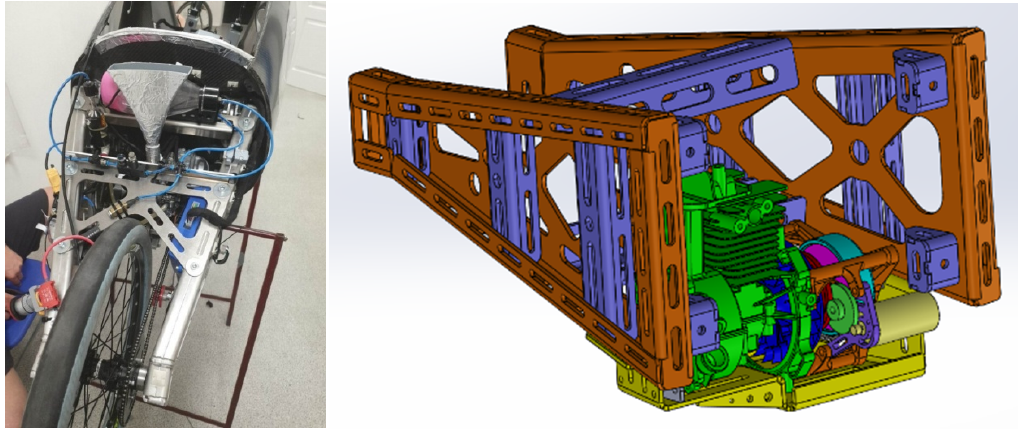
Figure 28. Completely assembled rear axle.